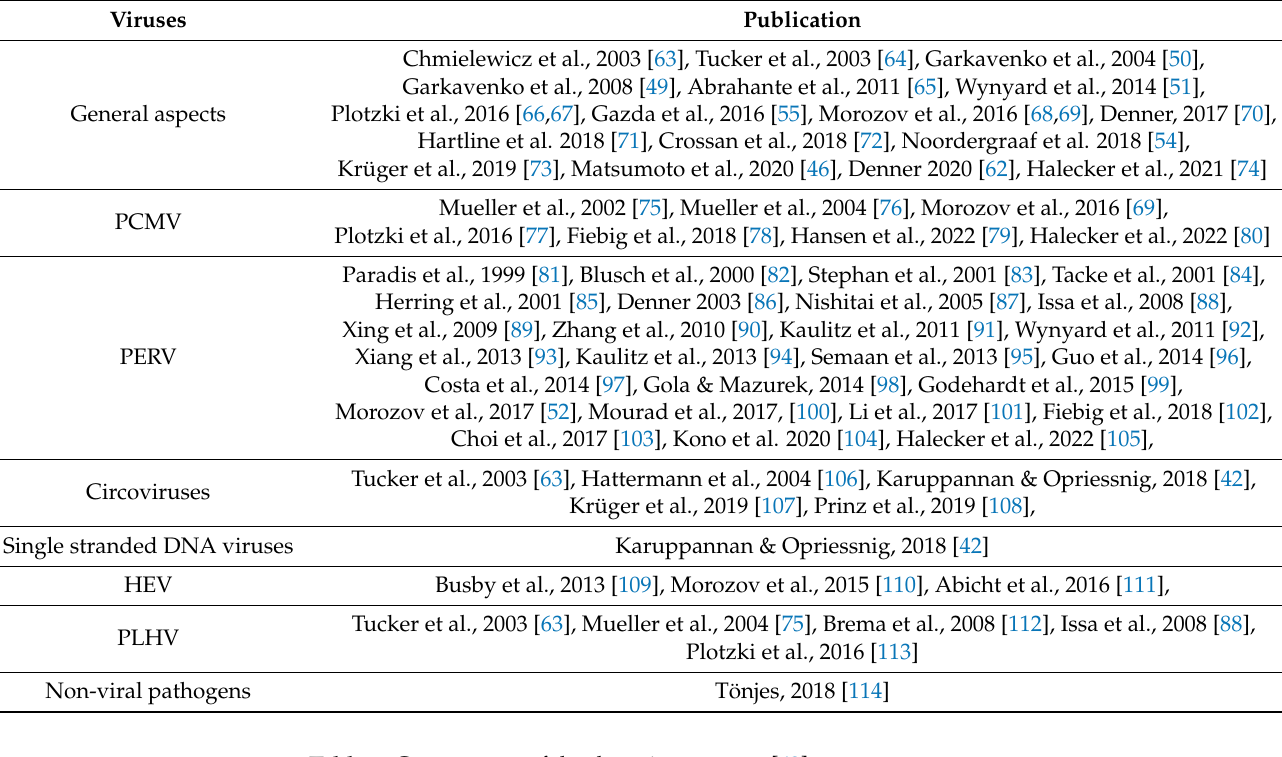
Table 6. Publications describing methods for the detection of potential zoonotic porcine viruses in the context of xenotransplantation.